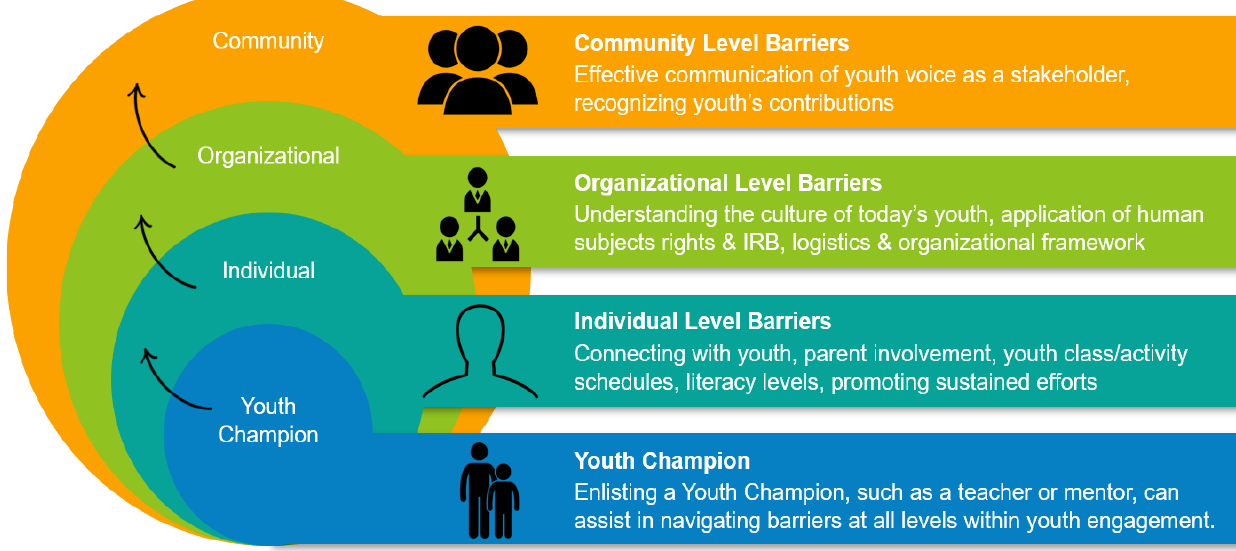
Figure 1. Overcoming challenges to authentic youth engagement.